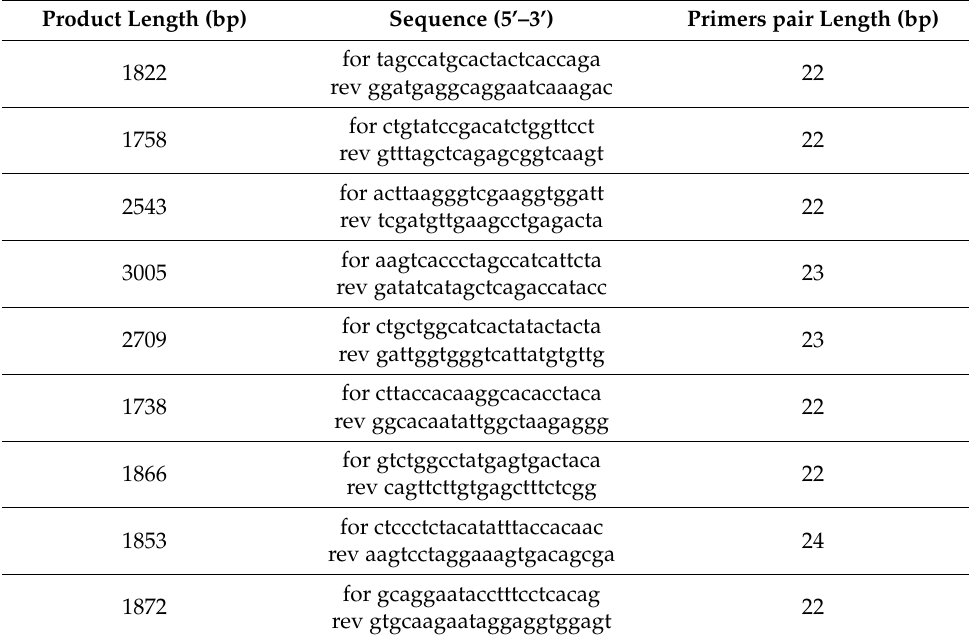
Table 3. Primer set for whole mtDNA genome amplification. The sequences of the forward and reverse primers, PCR product and primer lengths are presented